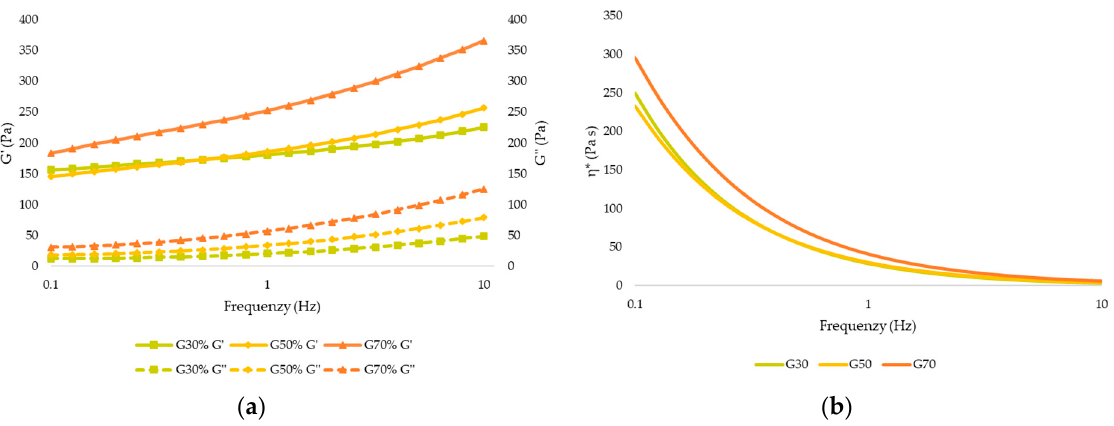
Figure 1. ( a ) Elastic modulus (G ′ ) and viscous modulus (G ″ ). ( b ) Complex viscosity ( η *) of the apricot gel before 3D printing (G30: Gel 30% pulp; G50: Gel 50% pulp; G70: Gel 70%